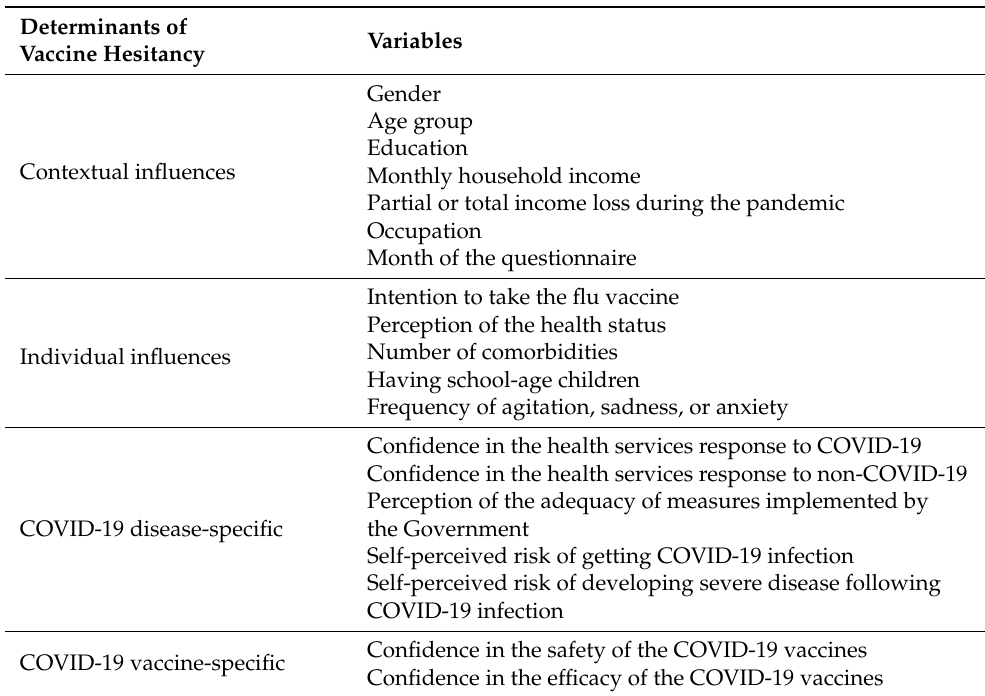
Table 1. Vaccine hesitancy determinant matrix recommended by the Strategic Advisory Group of Experts (SAGE) Working Group on Vaccine Hesitancy [12], with the fourth category specific to the COVID-19 disease